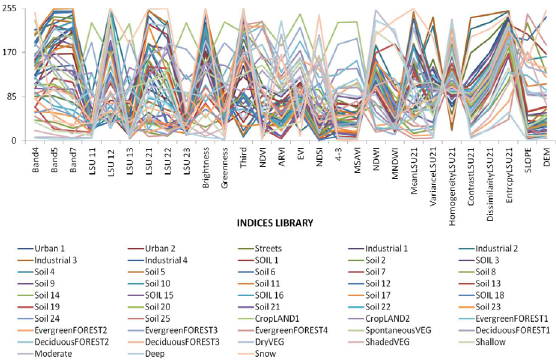
Figure 3. The spectral library, based on mean values, used to classify